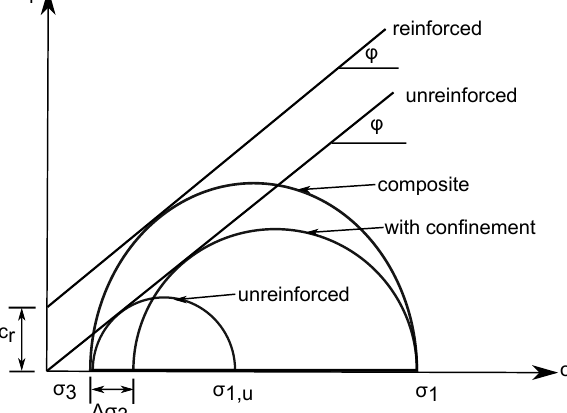
Figure 3. Mohr circles for unreinforced, reinforced and composite (geocell filled with crushed stone) ma- terial (Adapted after [11]) The values M = 450 MPa, d n = 0.43 and K p = 3 were used in this presented anal- ysis. The contact between the equivalent geocell layer and the surrounding soil was modelled by a contact element with the value of parameter R cording to the results of experiments published in